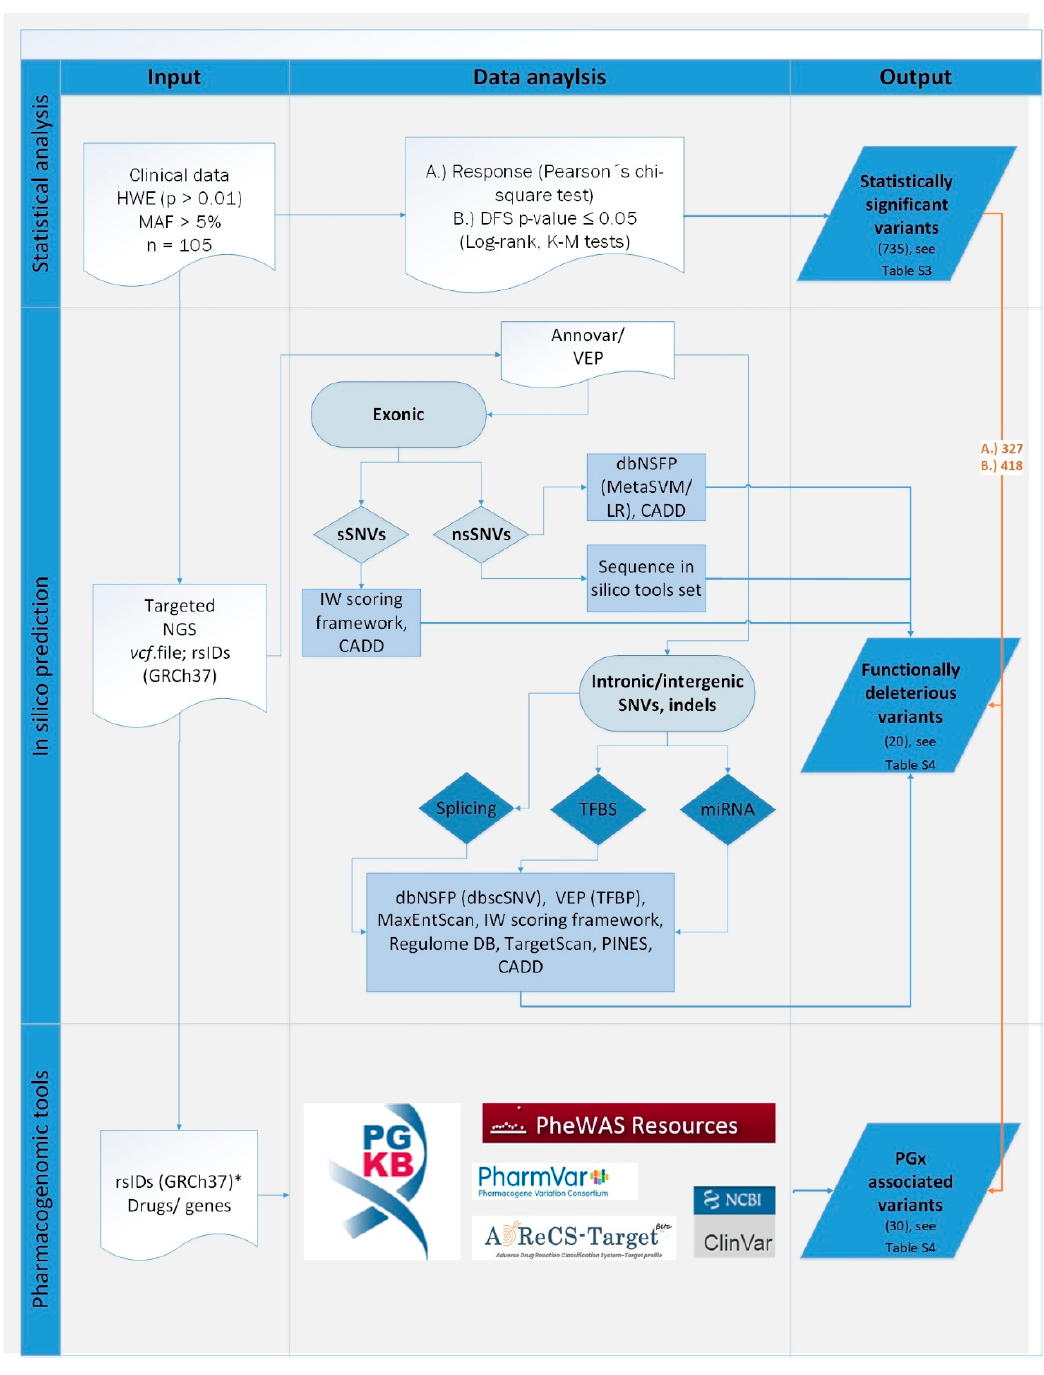
Figure 3. Variant prioritization scheme. Numbers of unique variants shared with statistically significant results are depicted in brackets. Statistical analysis using germline variants from targeted sequencing and clinical data of patients with Hardy-Weinberg equilibrium (HWE, p > 0.01) and Minor allele frequency (MAF > 0.05) was conducted to search for drug response (A) and (B) disease-free survival (DFS) associations. In silico prediction was applied on synonymous (sSNVs) and non-synonymous (nsSNVs) single nucleotide variants and indels from next generation sequencing (NGS) data in VCF format using several web-based and command-line software tools (see Section 4 Materials and Methods). In pharmacogenomic (PGx) databases with no batch or download option, only statistically significant variants were considered for manual curation (*). GRCh37 = Genome Reference Consortium Human Build 37 (hg19); TFBS = transcription factor binding site; TFBP = transcription factor binding profile.